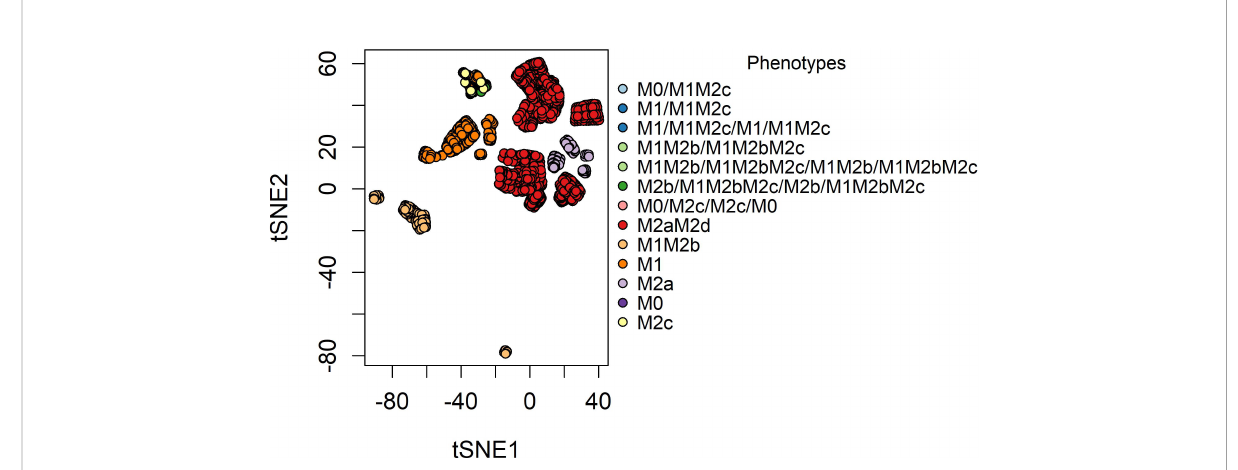
FIGURE 1 The t-SNE plot of the phenotypes was obtained from our network of macrophage polarization. The attractors were handed a point in an x - y plane based on the expression of 0 ’ s and 1 ’ s, and attractors with the same combination of 0 ’ s and 1 ’ s were placed